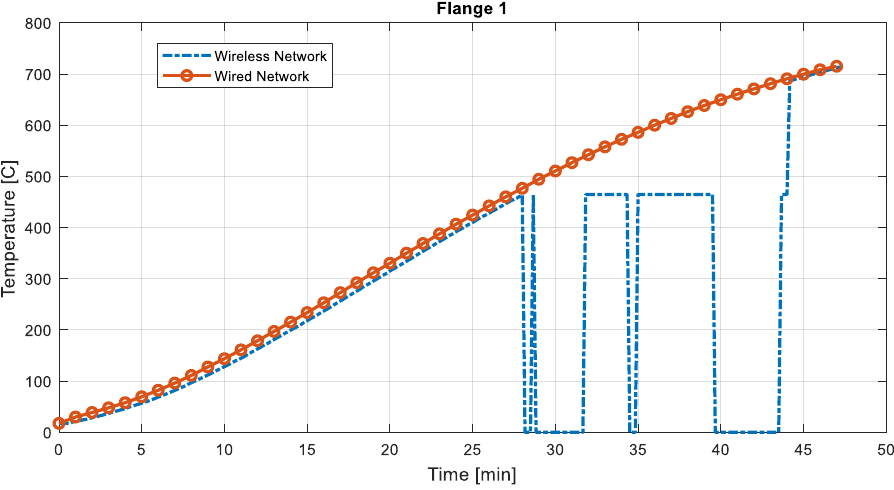
Figure 7. Temperature and time history measured at flange1 – full time.